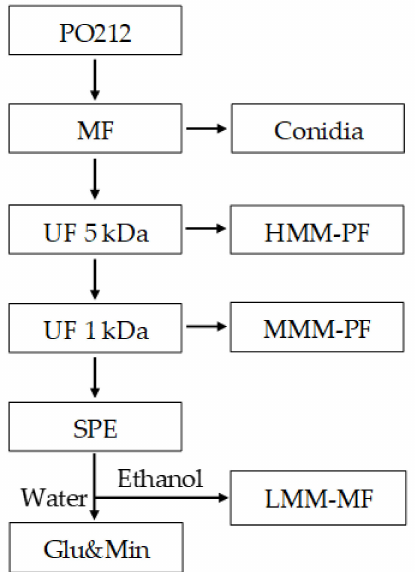
Figure 1. General diagram of the fractionation pathway of crude extract (CE7) of Penicillium rubens strain 212 (PO212) by tangential-flow ultrafiltration (UF) and solid phase extraction (SPE). MF: microfiltration; HMM-PF, high molecular mass (MM) protein fraction, MMM-PF, middle MM protein fraction, LMM-MF, low MM metabolic fraction, Glu&Min: glucose and mineral enriched